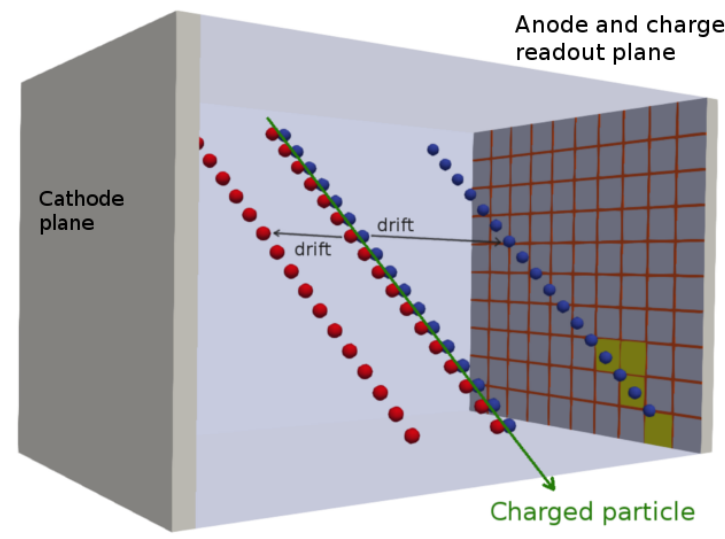
Figure 1. Illustration of the working principle of a TPC . Ionisation electrons (blue) and the ionised atoms (red) drift to the anode and the cathode,